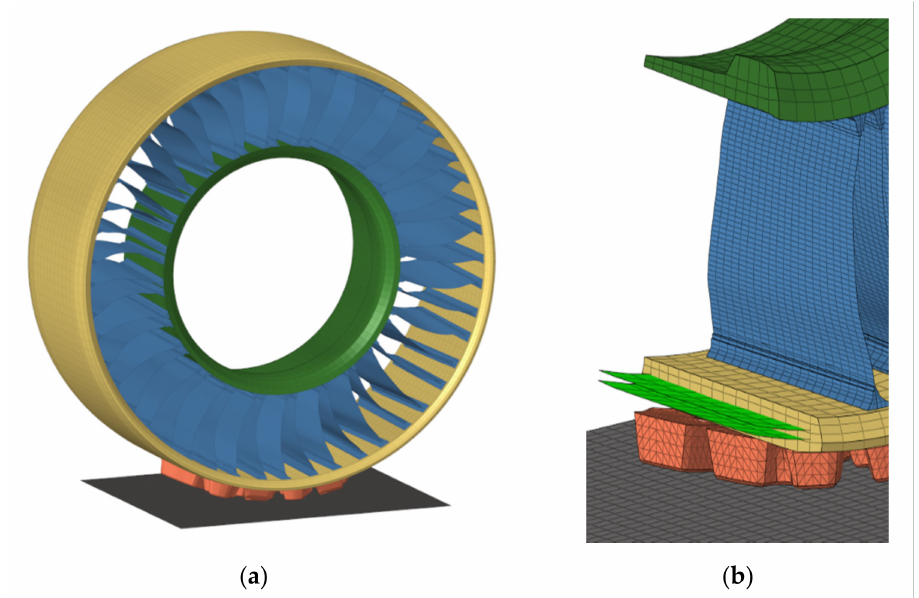
Figure 8. FE model of the Michelin X-Tweel UTV: ( a ) Entire FE model, ( b ) details of belt plies.